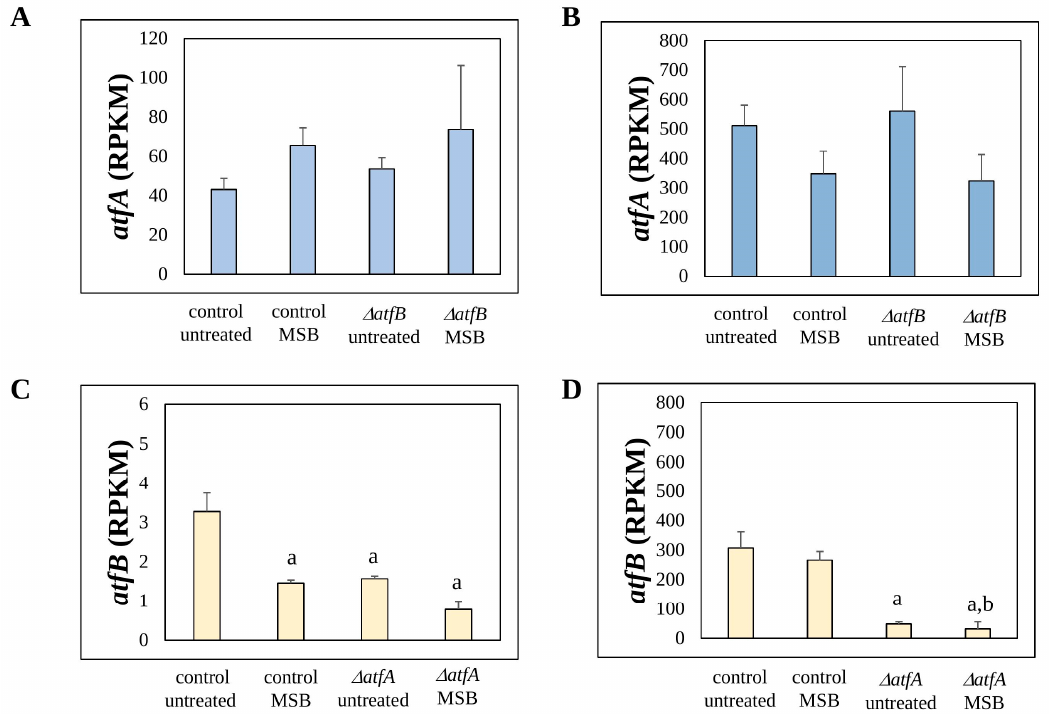
Figure 1. Transcriptional profile of the atfA and atfB genes. ( A , B ): Expression of atfA in MSB treated and untreated cultures of the wild type and the ∆ atfB strain. ( C , D ): Expression of atfB in MSB treated and untreated cultures of the wild type and the ∆ atfA strain. Mean ± SD RPKM values calculated from three biological replicates of mycelial ( A , C ) and conidial ( B , D ) samples are presented. a—downregulated gene relative to the untreated control cultures, b—downregulated gene relative to the MSB treated control cultures.